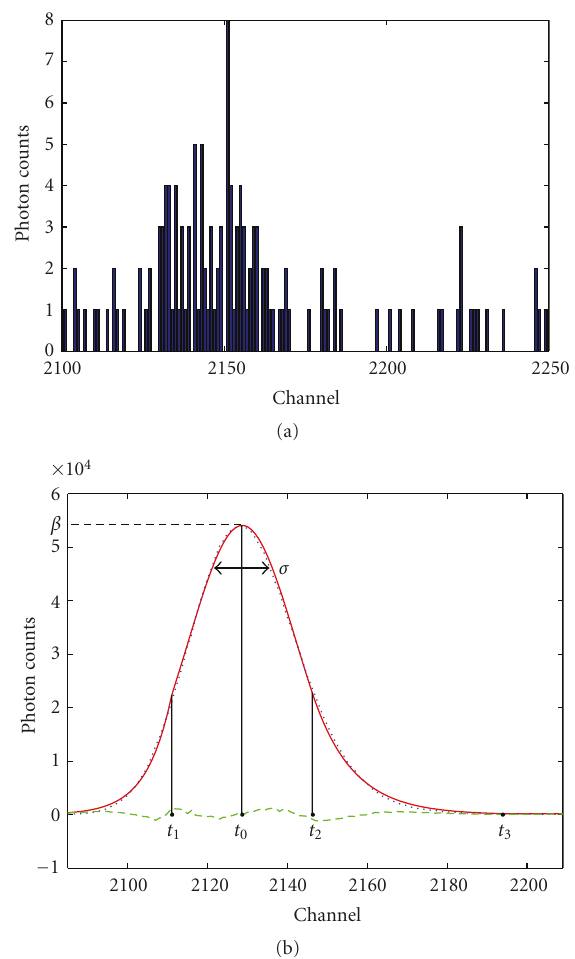
Figure 3: (a) A single magnified selected peak from Figure 2. (b) Instrumental response of TCSPC ladar signal (dotted line) and fitting result (solid line) using piecewise exponential model with fitting errors (dashed line). The parameter sets corresponding to (1) are: β = 5 . 41, t 0 = 2128 . 70, ( t 1 , t 2 , t 3 ) = (2111.15, 2146.36, 2193.93), ( τ 1 , τ 2 , τ 3 ) = (6.32, 10.04,